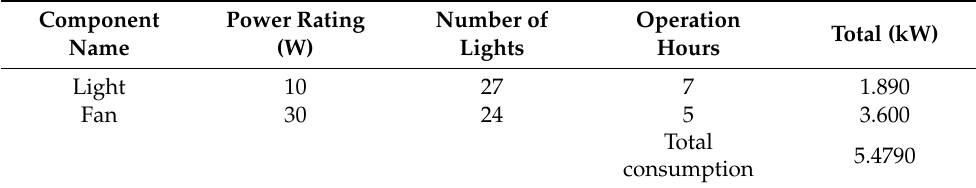
Table 3. Summary of load consumption for a typical big primary school building while the effect of a thin-film coating is